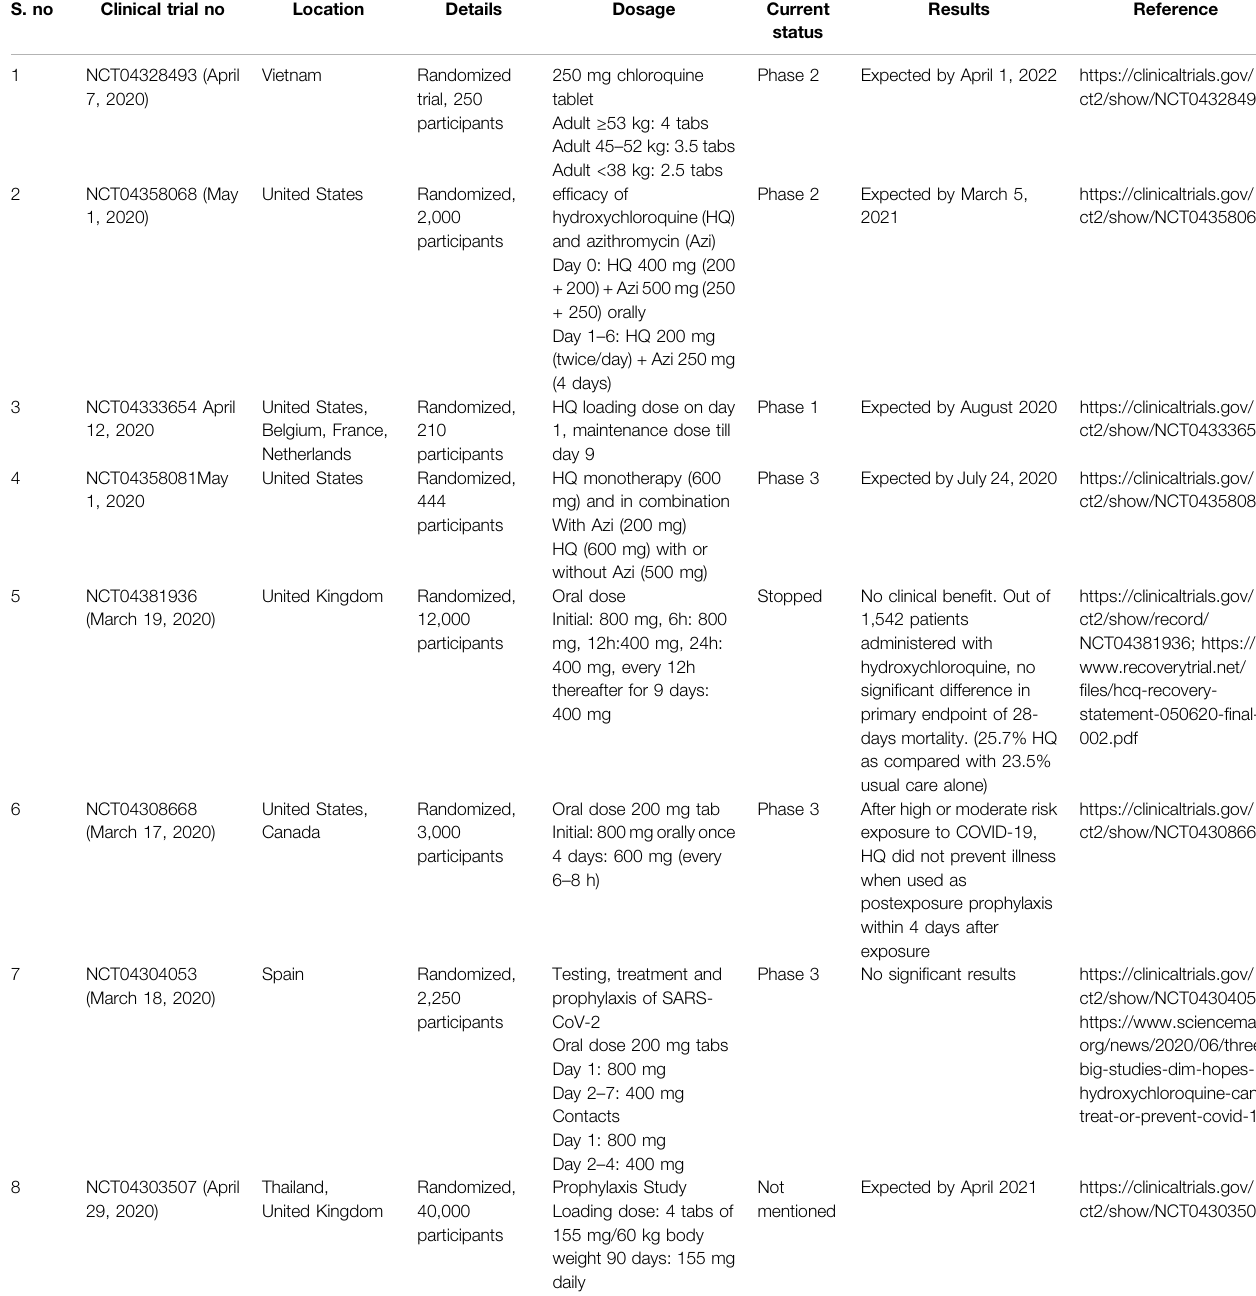
TABLE 5 | Ongoing clinical trials to evaluate the potential of chloroquine and hydroxychloroquine against SARS-CoV-2. S. no Clinical trial no